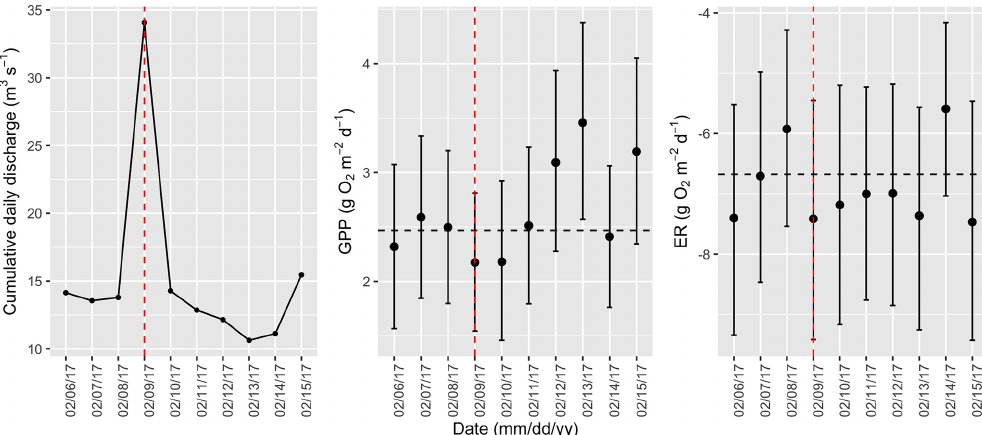
Figure A15. Cumulative daily discharge and metabolism (gross primary production and ecosystem respiration; GPP and ER) time series for the Stroubles Creek flow event on 9 February 2017 (noted with a dashed vertical red line in all three panels). The dashed horizontal black lines are mean values of GPP and ER prior to the high flow event. Error bars for posterior estimates of GPP and ER are 2.5% and 97.5% Bayesian credible